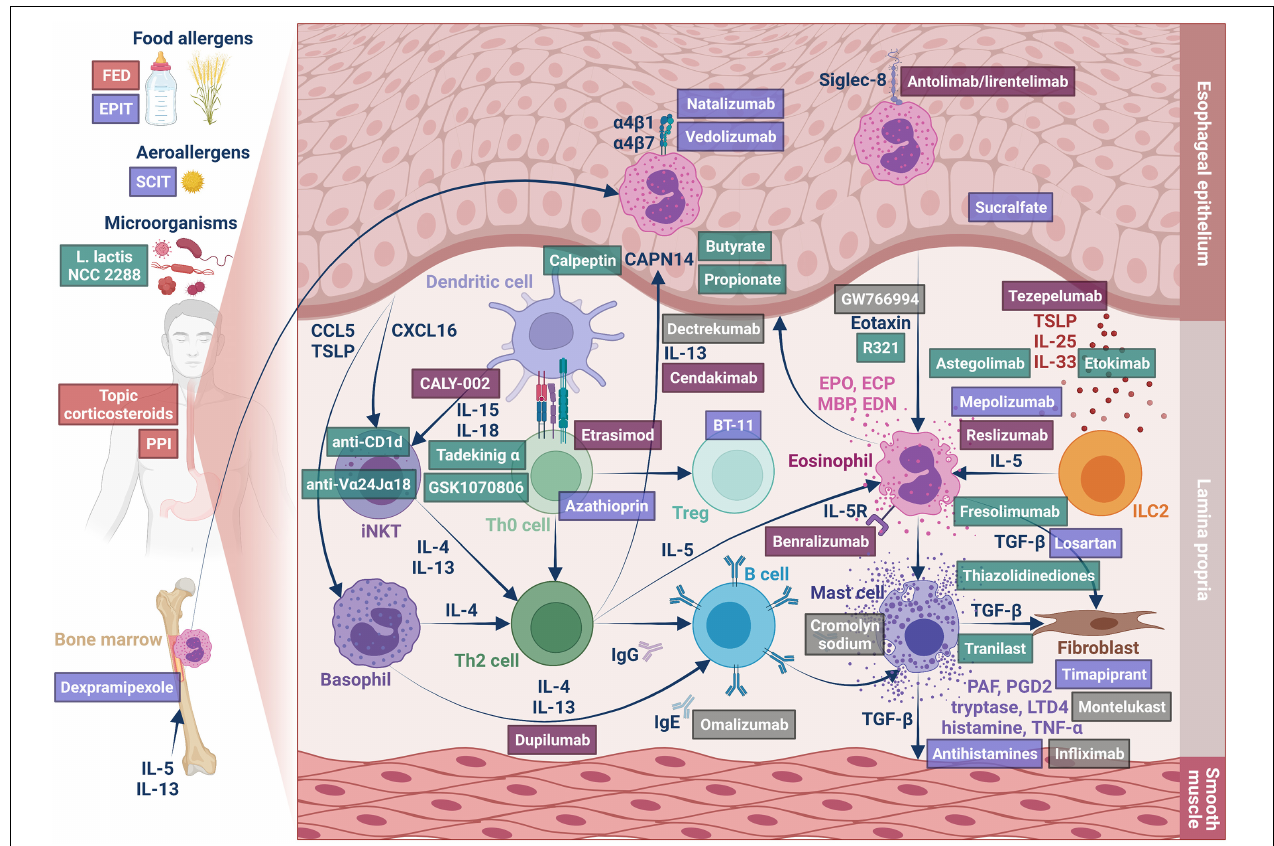
FIGURE 4 | Type 2 inflammation in EoE. The figure represents the involved cells and mediators and the therapeutic approaches described in the review. The drugs are colored as follows: Red tag: first-line therapy, Plum tag: orphan drugs, Lilac tag: drugs with reported results on human patients, Green tag: drugs without reported results on human patients, Gray tag: drugs that failed to obtain significant results on human patients.